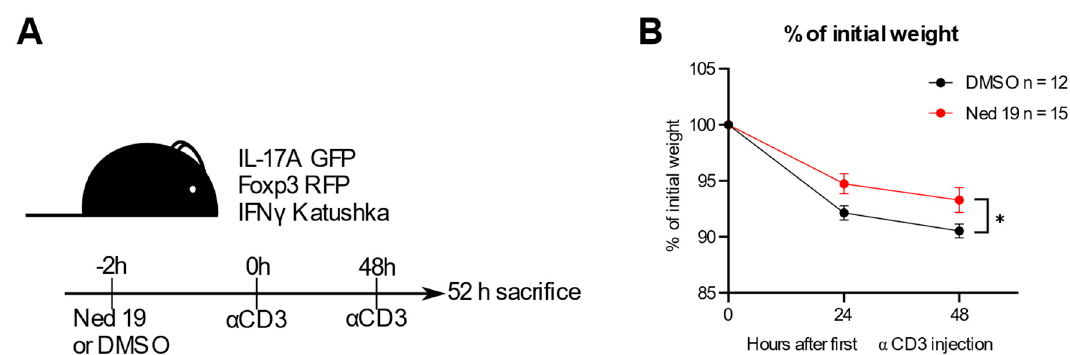
Figure 7. NAADP inhibition by trans-Ned 19 ameliorates course of disease in the anti-CD3 mAb induced duodenitis model. ( A ) Scheme of the experiment. IL-17A eGFP × IFN- γ Katushka × Foxp3 RFP triple reporter mice were injected DMSO or trans-Ned 19 2 h before first dose of anti-CD3 mAb. At 48 h, a second dose of anti-CD3 mAb was administered. The mice were sacrificed 4 h after second dose of anti-CD3 mAb. ( B ) Percentage of initial weight. p -Value was calculated with 2-way ANOVA. * p < 0.05.